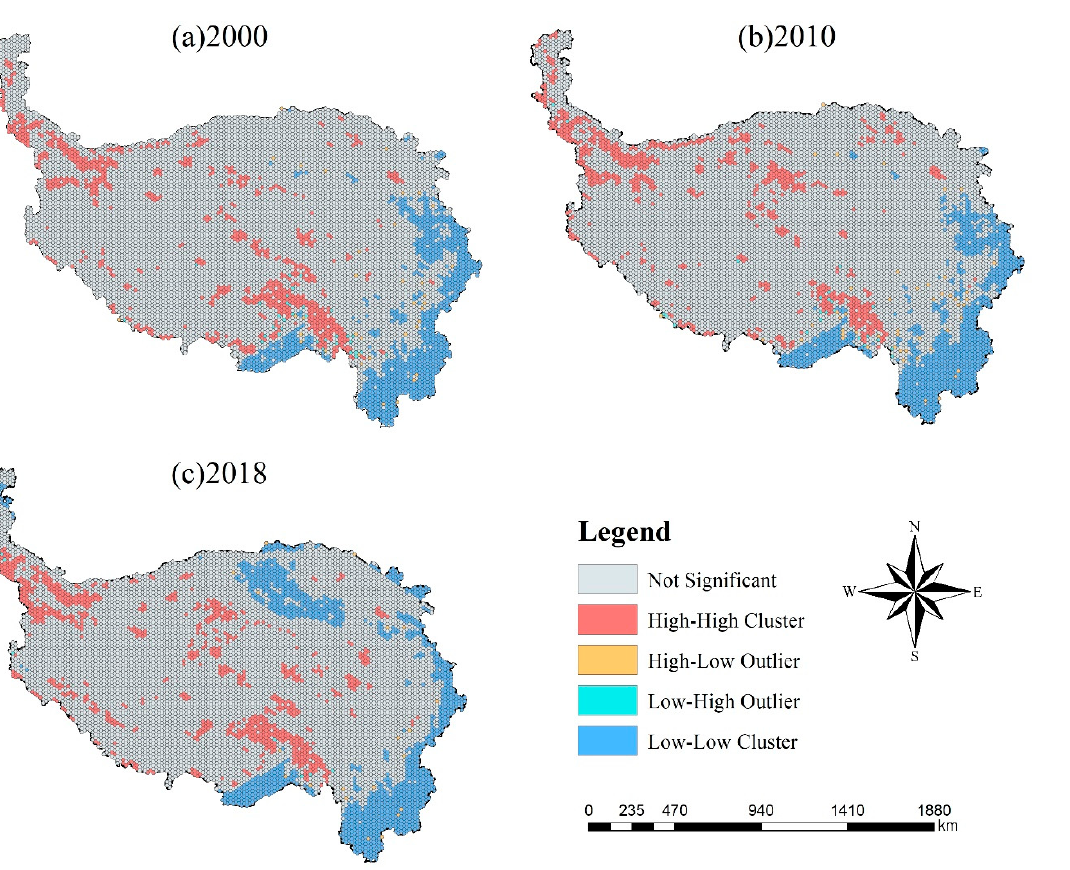
Figure 3. LISA (local indicator of spatial association) aggregation of the remote sensing ecological vulnerability index on the Qinghai-Tibet Plateau in 2000 ( a ), 2010 ( b ), and 2018 ( c ).